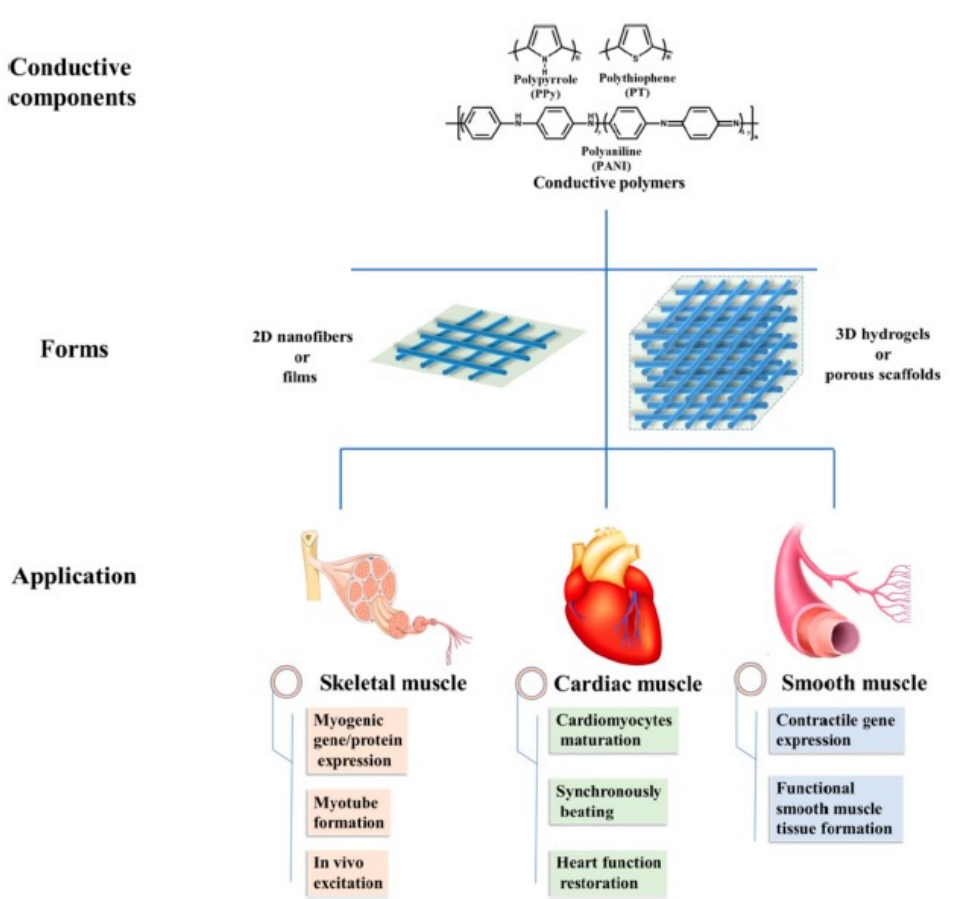
Figure 11. Main conductive materials, scaffold forms, and applications in muscle tissue engineering. Reproduced from [164] with permission. Copyright 2020 Omid Yousefzade et al.